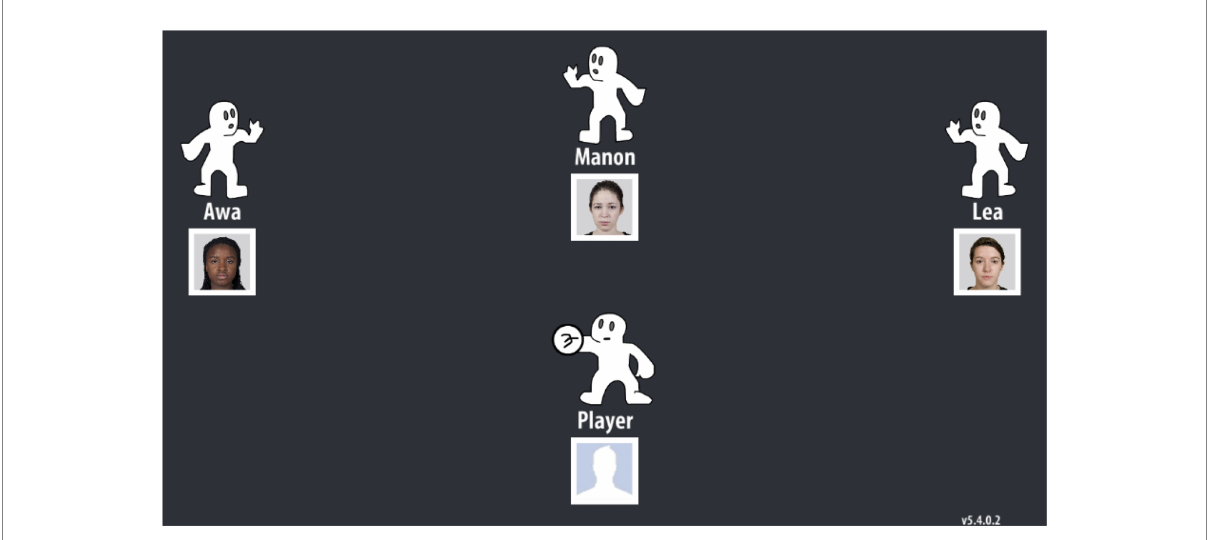
FIGURE 1 Illustration of the cyberball game for female participants. The bogus players’ images were taken from the Langner et al. (2010) radboud faces database. Reproduced with permission from Langner et al. (2010), available at: